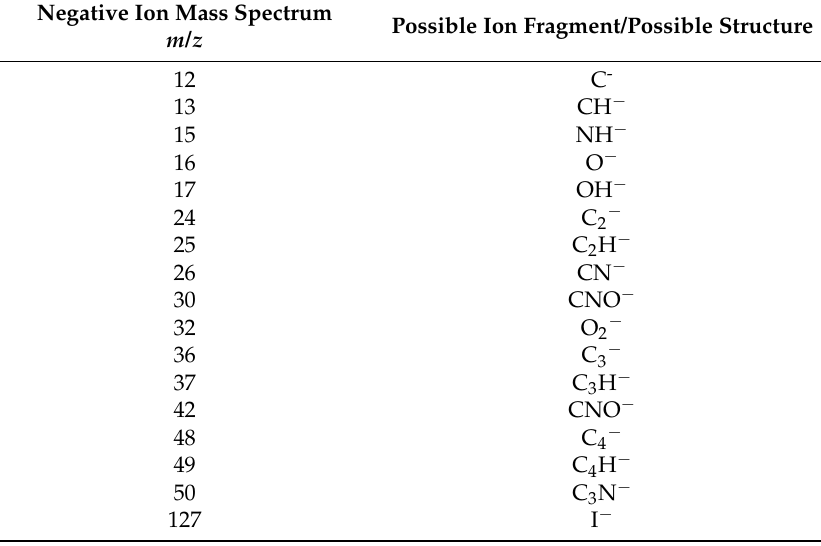
Figure 7. Negative-ion time of flight secondary ion mass spectrometry (ToF-SIMS) spectra (0–200 amu) of PANI film surfaces grown on glass substrates when using advanced APPJs device after 60 min deposition: ( a ) without I 2 doping; ( b ) with 30 s I 2 doping; and ( c ) with 120 s I 2 doping following deposition. Table 3. Selected peaks and their assignments observed in negative-ion time of flight secondary ion mass spectrometry (ToF-SIMS) spectra of PANI.